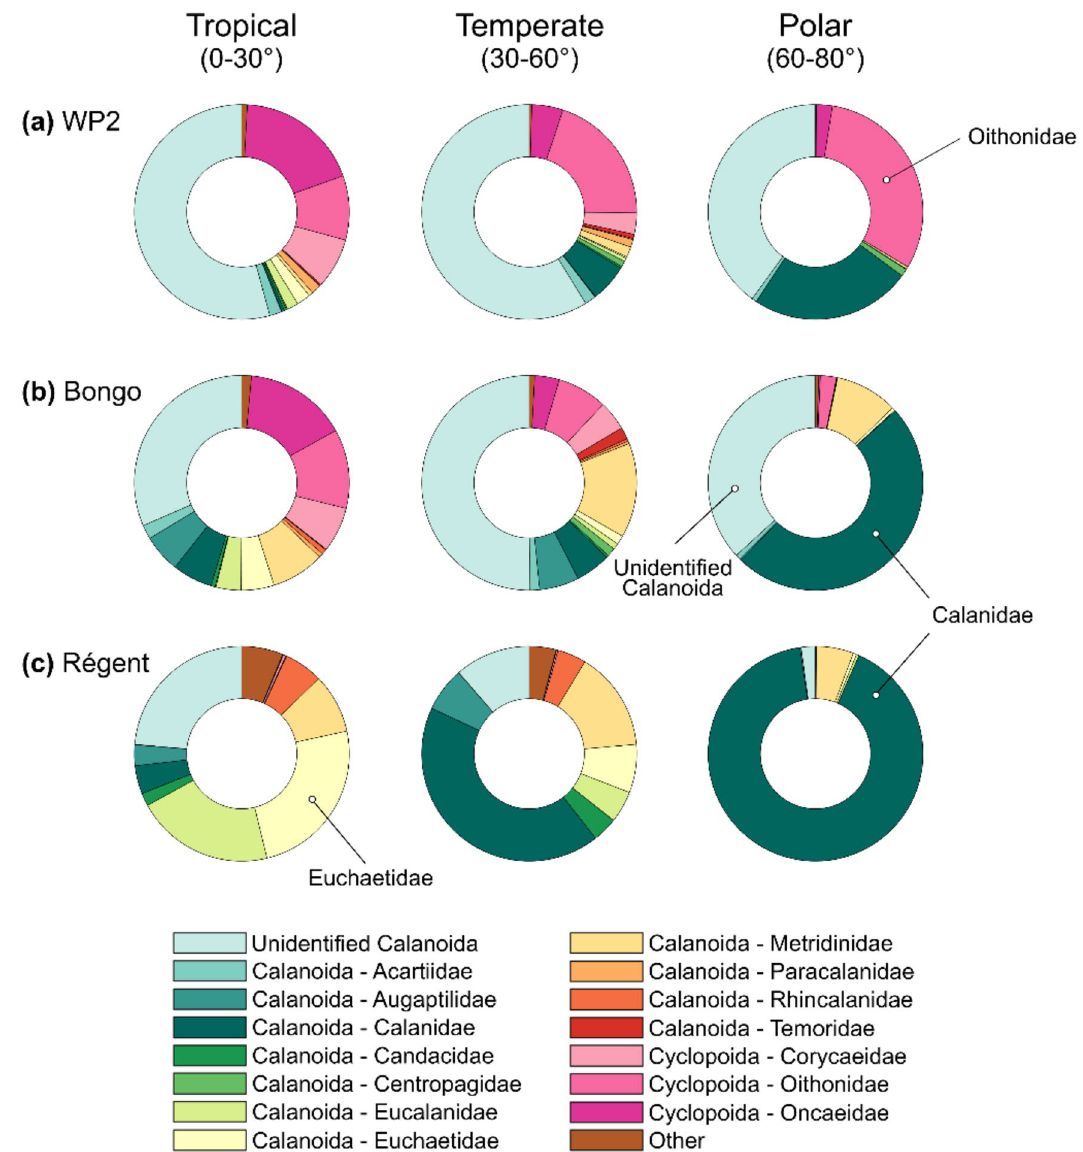
Figure 2. Variations in Copepoda community composition across the tropical (0 – 30°), temperate (30° – 60°) and polar (> 60°) latitudinal bands, depicted through the changes in relative abundances of the copepod Orders (Calanoida, Cyclopoida and Poecilostomatoida) and Families sampled by the ( a ) Bongo net, ( b ) WP2 net, and ( c ) Régent net. Taxa with lower than 1% are not shown. Unidentified categories correspond to those organisms that could be assigned to an Order but not to a Family because of the limited resolution of the imaging